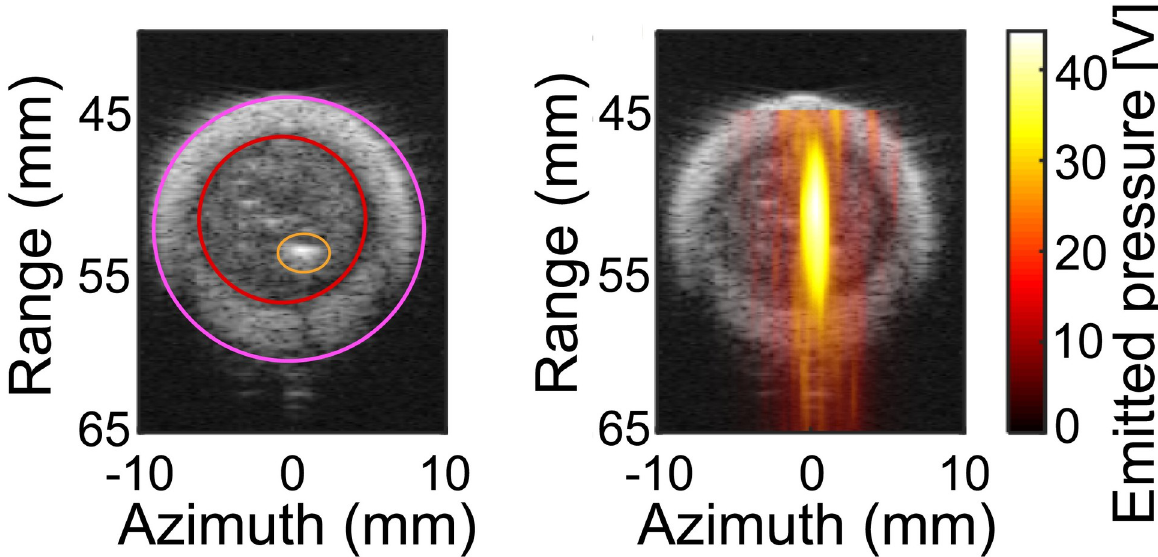
Fig 2. (Left) Segmented B-mode indicating the lumen (pink red line), clot (red line), and catheter (orange line). (Right) Duplex passive cavitation (hot colormap) and B-mode image. The histotripsy pulse propagates from top to bottom in this image. The pixel intensity is proportional to